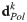
Block diagram of latent variable superposition model and schematic of the relationship between polarity direction, leading edge and direction of maximum stiffness.A: The ECM changes its latent state with the autoregressive feedback through matrix G as well as with the feedforward path which collects the latent variable states of all the individual cells zc,k(k = 1, …, ncell) through matrices Dk. Each cell changes its latent variable state with autoregressive feedback through A and are exposed to the ECM forces represented by latent vector ze in two separate paths. The path through the cell polarity block and matrix B can be viewed as an “active input”. This feedback path includes a cell’s internal decision as to which direction it extends lamellipodia. In contrast, the other feedback path through a gain matrix C does not have a high-level cell decision, but is reactive, playing a “passive role”. B: The cell polarity direction rotates dynamically in such a way that the polarity vector dPolk may align with the direction of the maximum stiffness dMax-Stiffe,k. The leading edge of the cell is indicated by a right circular cone with apex angle 2αLk having its centerline aligned with the polarity direction. The membrane nodes of the k-th cell within the cone have nonzero lamellipodial forces (FL,ic,k≠0). Membrane nodes outside this cone have zero lamellipodial forces (FL,ic,k=0).